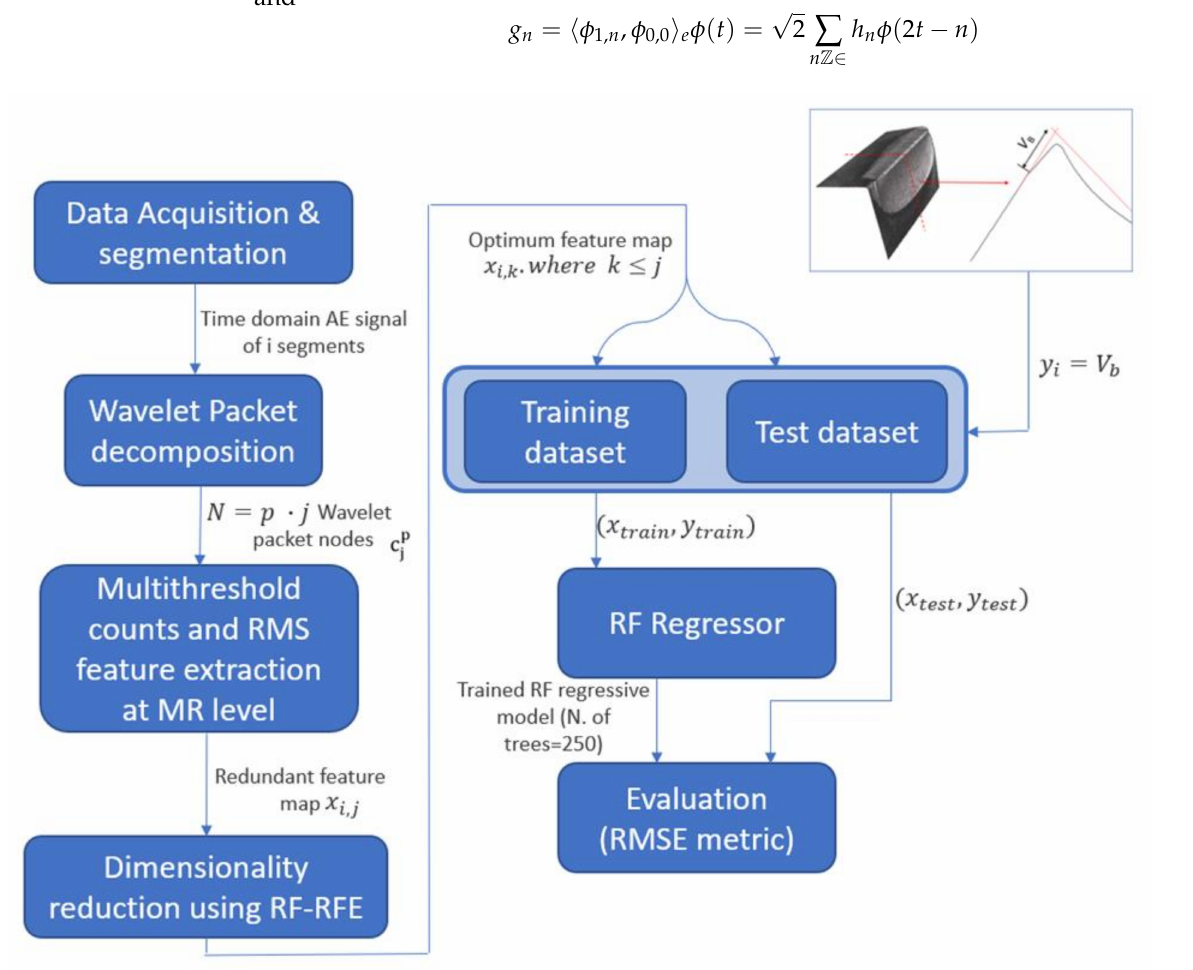
Figure 1. Graphical description of the proposed methodology. These two sequences are the base of the